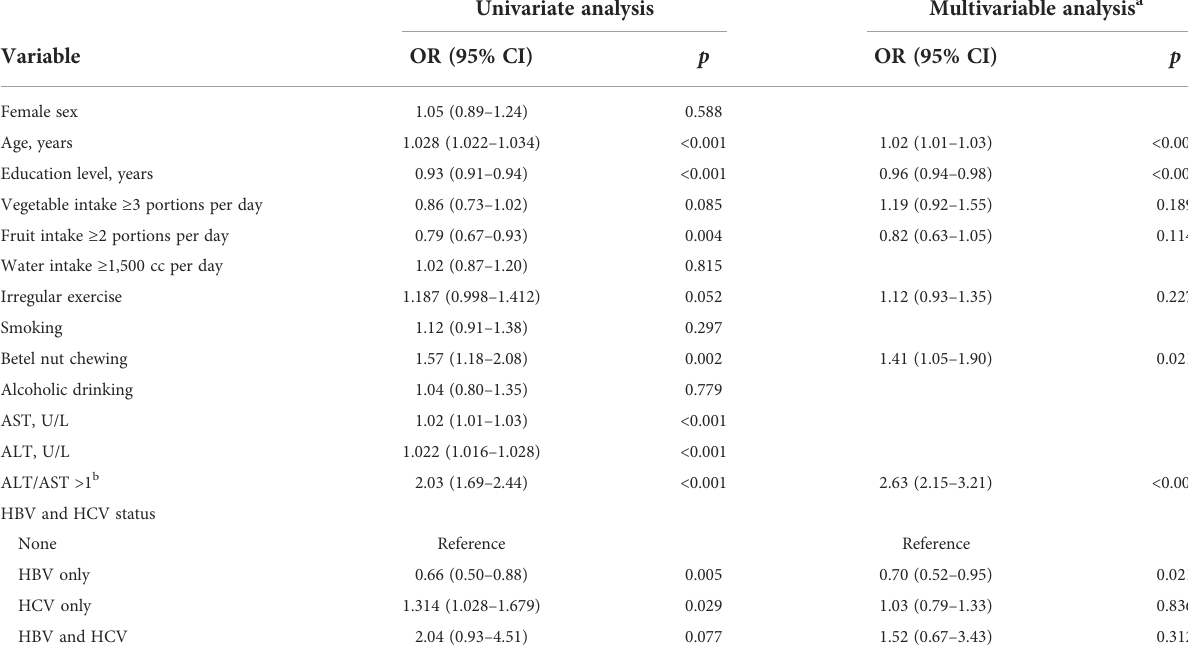
TABLE 3 Association between demographics/characteristics and the risk of metabolic syndrome ( N =